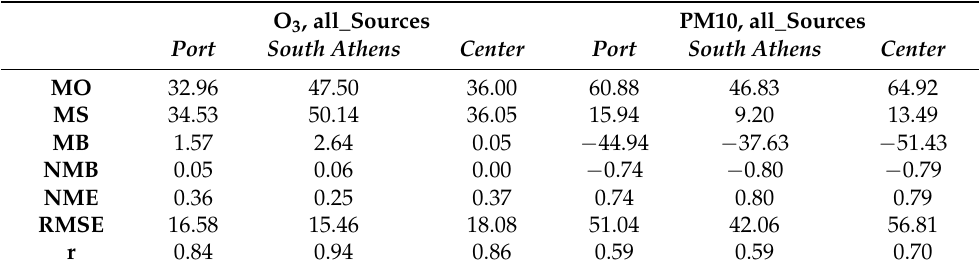
Table 10. Statistical parameters for the evaluation of model concentrations for 16 March 2022. O 3 ,